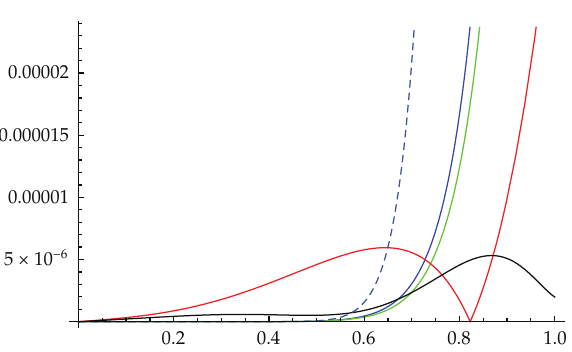
Figure 1: Plots of the residuals, blue: ADM, green: NIM, red: HPM, black: OHAM and dashed: DTM. In this figure, a comparison of the residuals is shown graphically, and it reveals that OHAM is more suitable technique for this problem. One can easily observe that the curve of the OHAM residual is approximately normally distributed while the curves of the residuals of other methods are J -shaped and highly skewed.